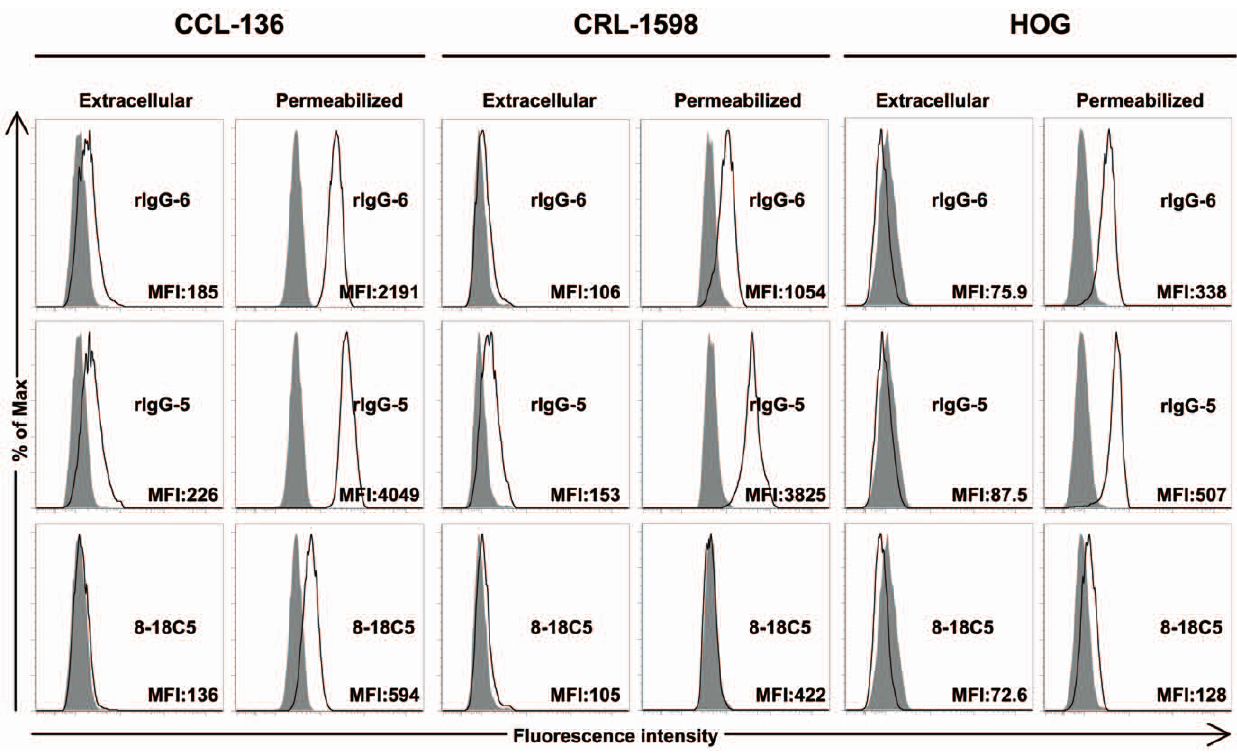
Figure 3. Cell-based assays to evaluate muscle-derived recombinant IgG autoreactivity. Recombinant IgG was prepared from single muscle tissue-associated plasma cells. A flow cytometry-based assay was then used to evaluate the binding of this rIgG to human muscle cell lines CCL-136, CRL-1598 and the human CNS-derived oligodendrocyte cell line, HOG. Representative positive staining shown in the histograms is indicated by an increase in median fluorescence intensity (MFI) of the IBM-derived rIgG (open curves) in comparison to staining with the secondary antibody alone (anti-human IgG-Alexa Fluor 647). A humanized monoclonal antibody, 8-18C5, specific for myelin oligodendrocyte glycoprotein served as negative control. The evaluation of extracellular binding revealed a modest increase in MFI for rIgG-5 (open curves) and rIgG-6 (open curves) with respect to the secondary antibody for both muscle-derived cell lines, but not the CNS-derived cell line. Both rIgG-5 and rIgG-6 demonstrate detectable binding to all three permeabilized cell